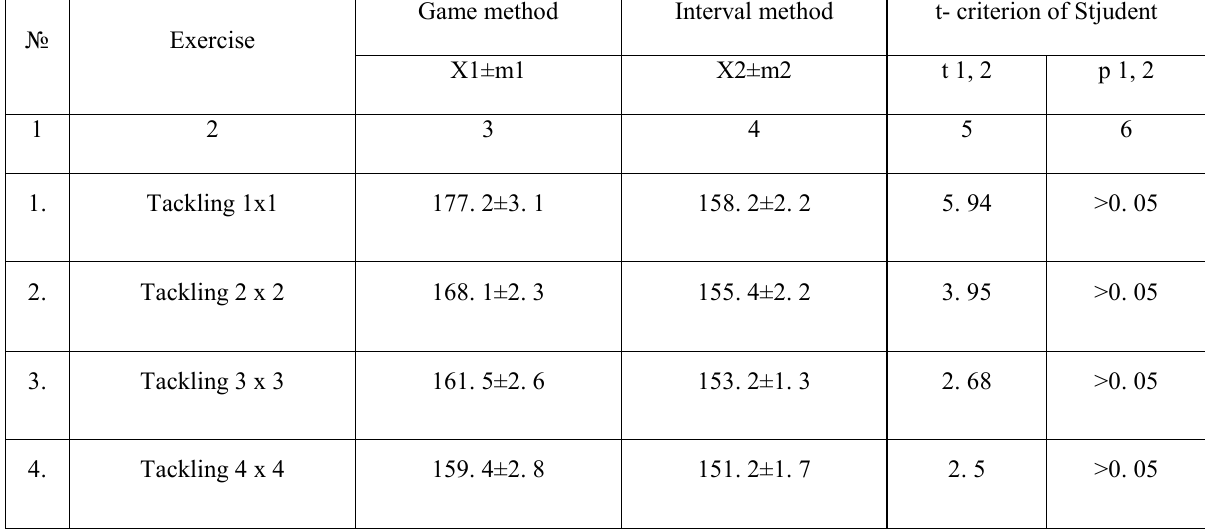
Mean indicators of HBR of 10-12 years old football players in football exercises with application of different methods (n=24) Game method Interval method